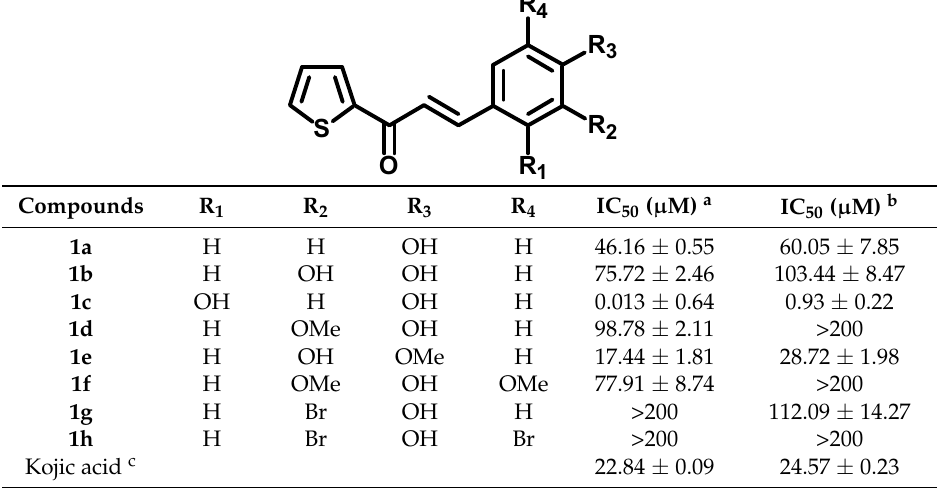
Molecules 2018 , 23 , x